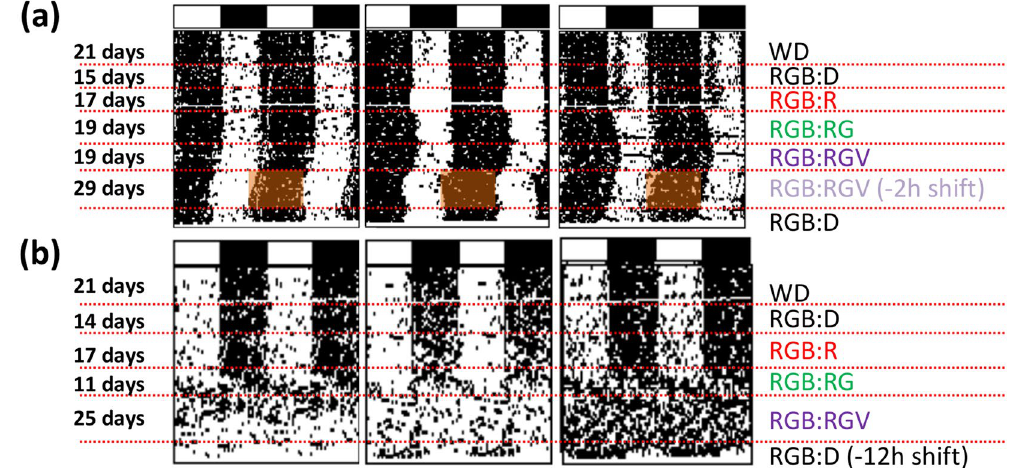
Figure 1. Actograms. Representative wheel running activity (WRA) double-plotted actograms from three degus ( a ) and three rats ( b ). White and black bars at the top of the actograms represent the daytime period (12 h) and night-time phase (12 h), respectively. Different light cycles throughout the experiment are shown on the right and indicated by dashed lines in the actograms. Animals were exposed to a combined red-green-blue LED (RGB) illumination for 12 h during the day. At night, they were subjected to different conditions: i) darkness (D); ii) red lights (R); iii) combined red-green LED (RG) lights; and iv) combined red-green-violet LED (RGV) lights. The ( − 2 h shift) indicates a 2 h phase advance of the RGB:RGV schedule (in degus) or a 12 h phase advance ( − 12 h shift) of the RGB:D cycle for rats. For more details on the lighting conditions, please see the methods